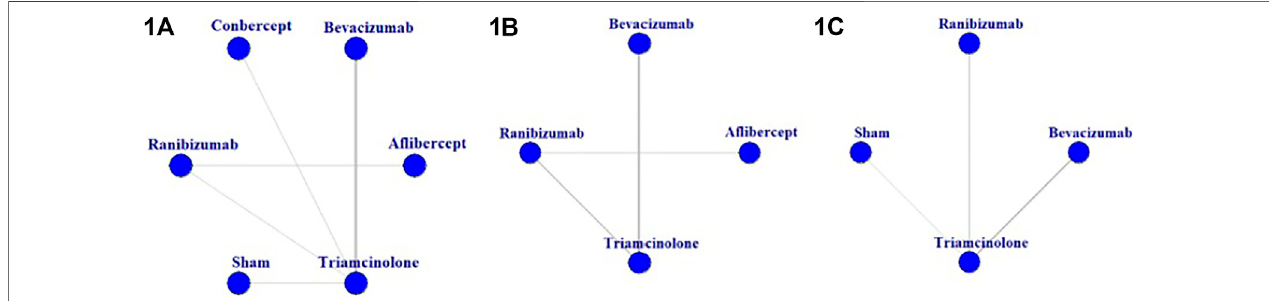
FIGURE 2 | Network of eligible comparisons for the meta-analysis of (1A) best-corrected visual acuity at 6 months; (1B) central macular thickness at 6 months; (1C) intraocular pressure at 6 months.